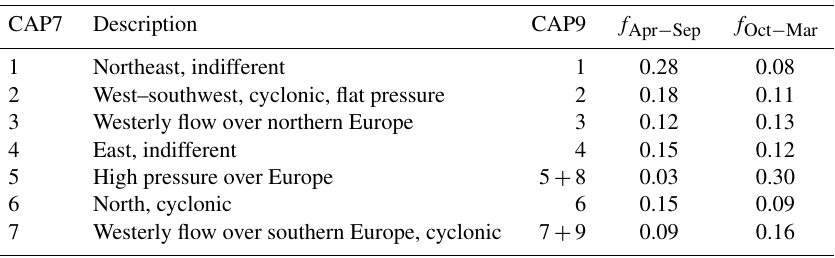
Table 1. Description of CAP7 weather types, corresponding CAP9 types, and frequencies in the cold and warm season in the period 1961– 1990.